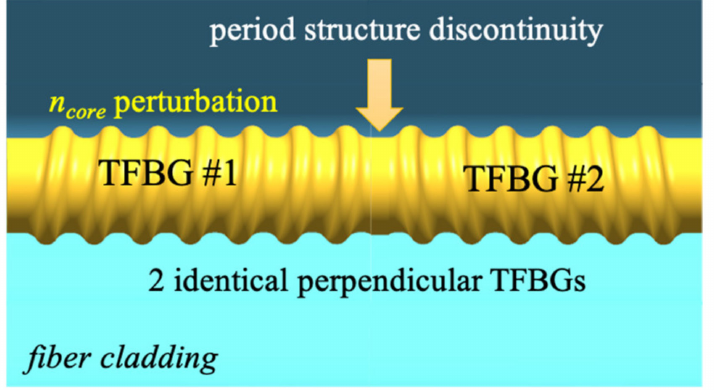
Figure 13. Structure composed of two identical TFBG twisted in relation to each